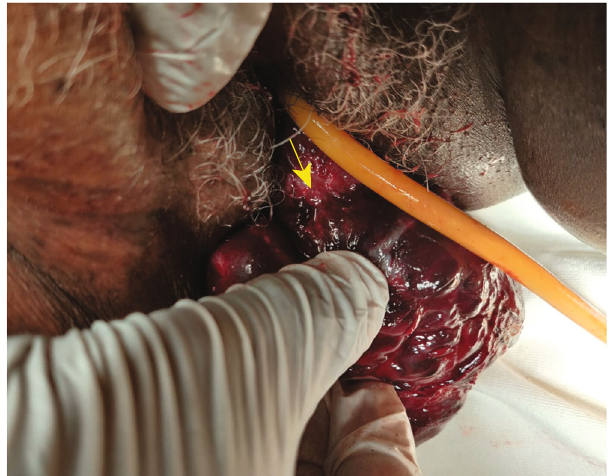
Figure 2: Tight cervical ring (yellow arrow) behind the